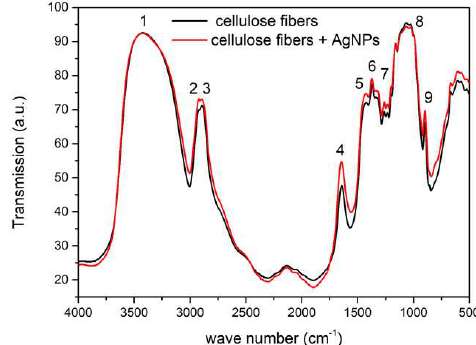
Figure 4. FTIR spectrum for pure cellulose fiber (black line) and the fiber doped with silver nanoparticles with PEI (red line).